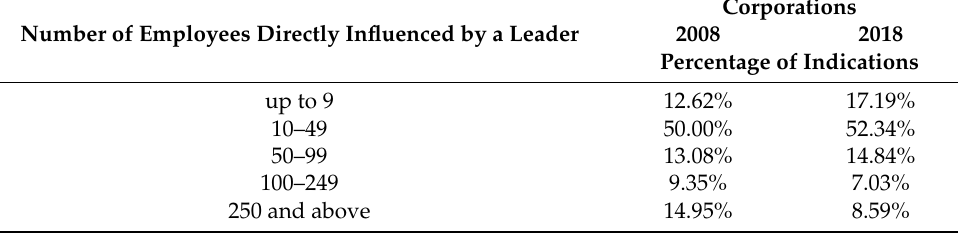
Table 1. Number of employees under a leader’s direct influence as viewed by leaders of the Forbes Global 2000 world’s largest corporations.